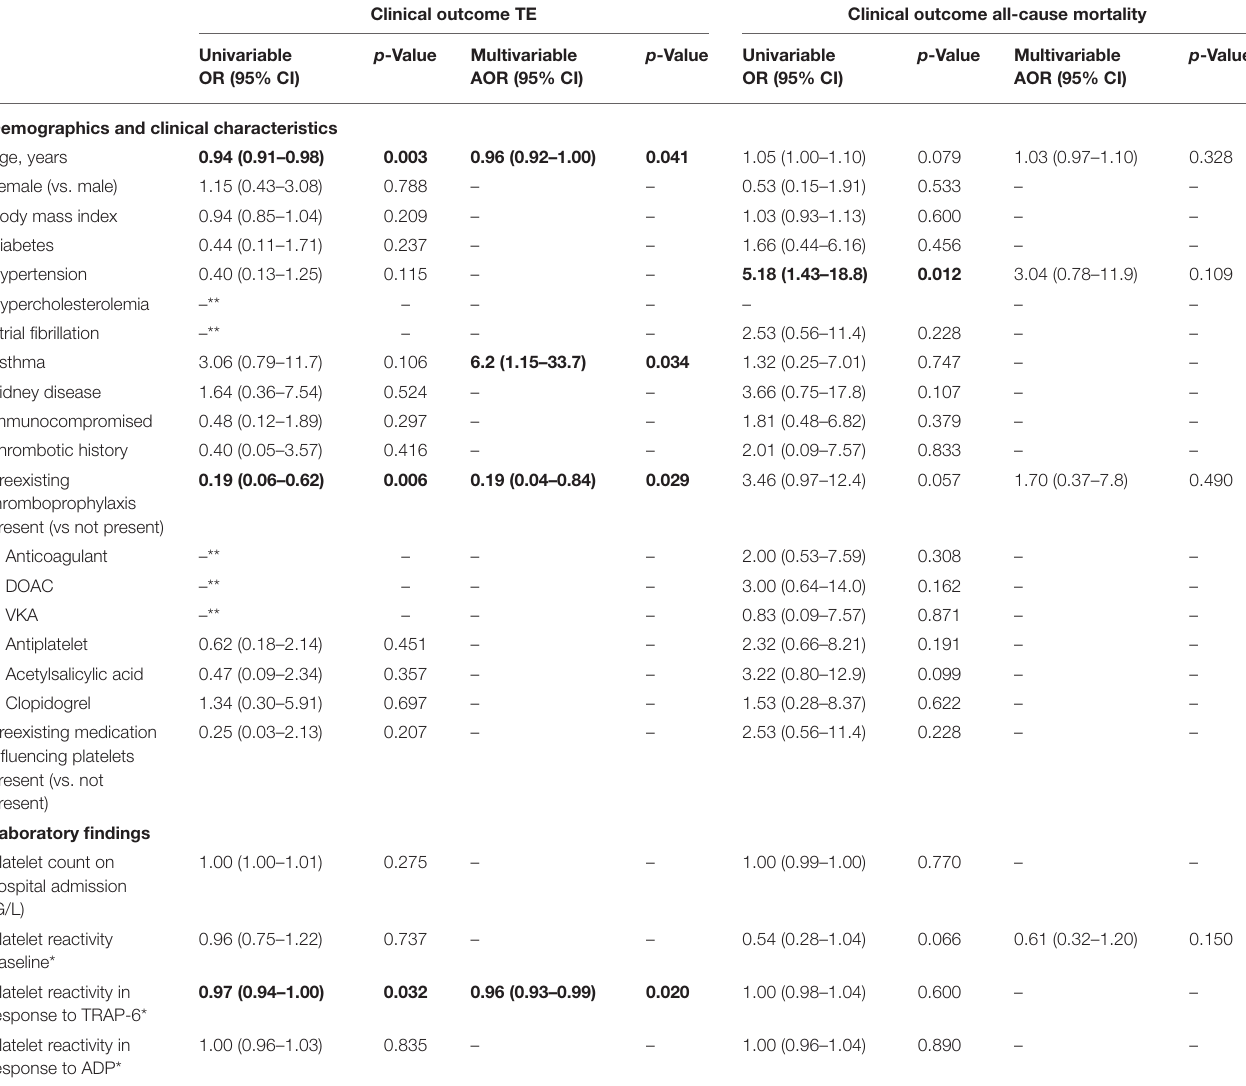
TABLE 3 | Risk factors associated with TE and all-cause